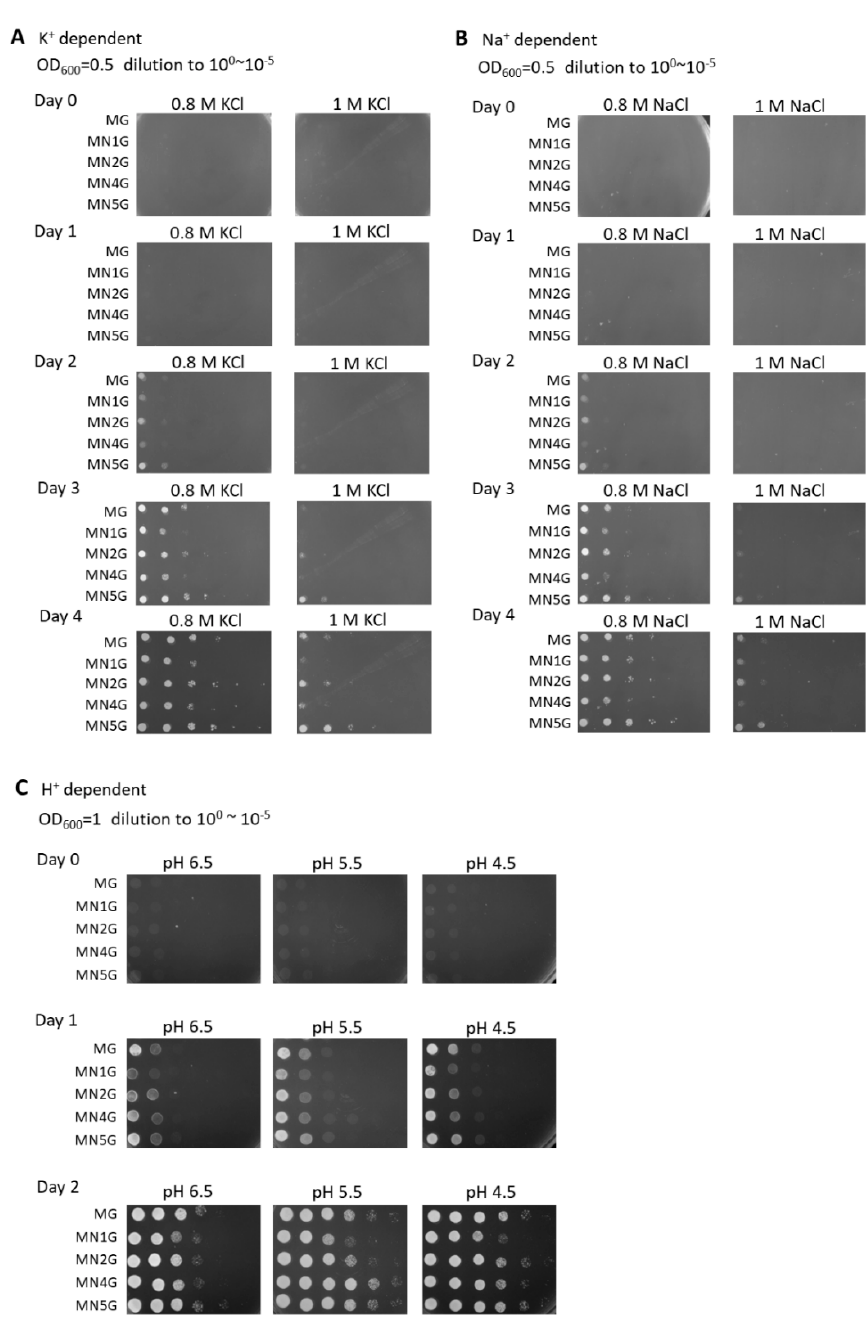
Figure 8. K + , Na + , or H + -dependent growth phenotypes of yeast transformants. ( A ) Yeast transformants were cultured to saturation for 15 h in 3 mL SC-U medium plus 2% glucose and diluted from OD 600 = 0.5, and were then pipetted as a 1:10 dilution series onto SC-U medium plus 2% galactose agar plates with the addition of 0.8 M NaCl or 1 M NaCl. The white colonies indicate 10 0 ~10 − 5 series diluted cells from left to right and were observed from day 0 to day 4. ( B ) Yeast transformants were cultured and treated as above except with the addition of 0.8 M KCl or 1 M KCl. The white colonies indicate 10 0 ~10 − 5 series diluted cells from left to right and were observed from day 0 to day 4. ( C ) Yeast transformants were cultured to saturation for 15 h in 3 mL SC-U medium plus 2% glucose and diluted from OD 600 = 1, and then were pipetted as a 1:10 dilution series onto SC-U medium plus 2% galactose agar plates at pH 6.5, pH 5.5, or pH 4.5. The white colonies indicate 10 − 1 ~10 − 6 diluted cells from left to right and were observed from day 0 to day 2.